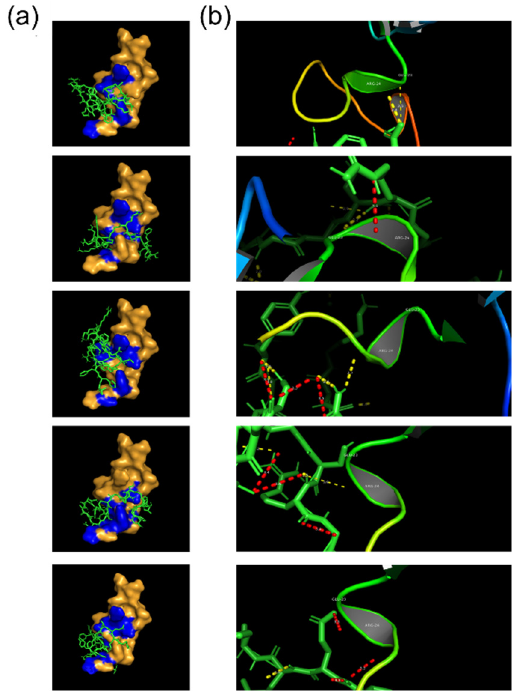
Figure 4. Simulation of Angioepep-2/CR17 binding: molecular docking results; ( a ) 3D representation of angiopep-2 binding site on CR17 (in blue); ( b ) details of Angiopep-2/CR17 binding (dotted line in yellow represents pi interaction, in red electrostatic clashes). Table 2. Binding of angiopep-2 to CR17 of LRP-1: characteristic binding energy and classification of receptor residues involved in the binding.